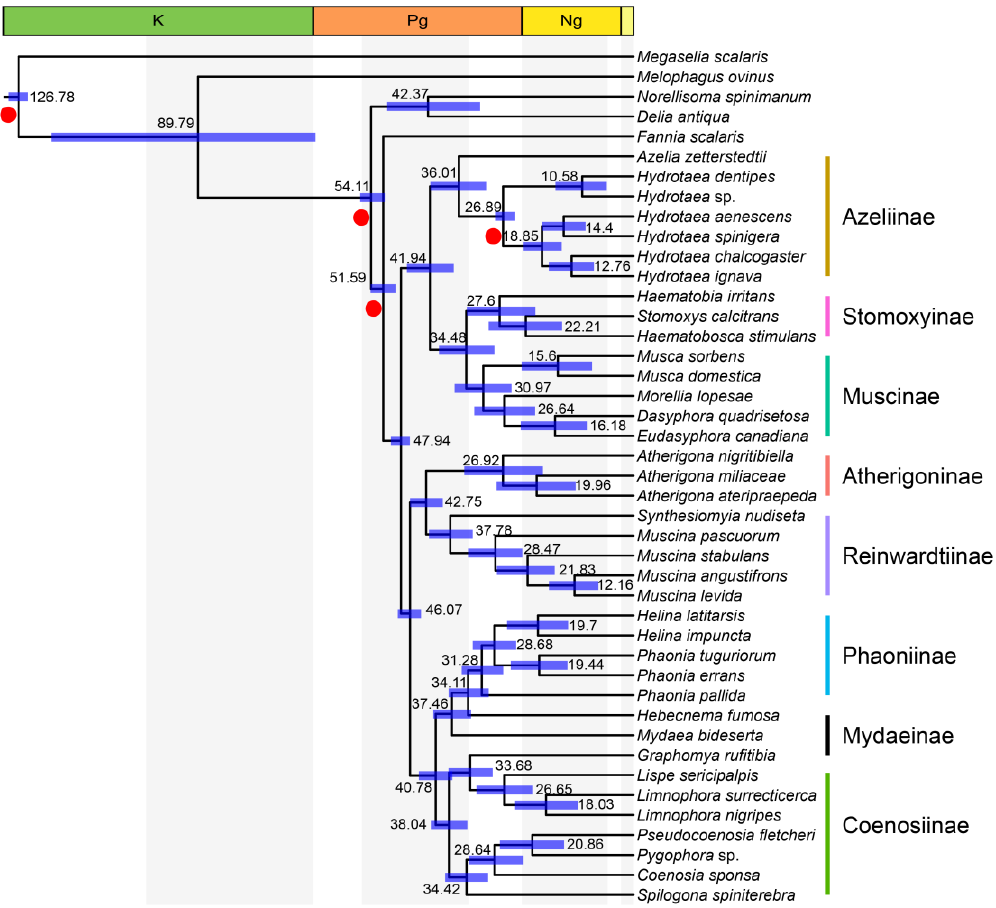
Figure 4. Estimation of Muscidae divergence time by MCMCTree . Different vertical color stripes represent subfamilies in Muscidae; the red points on nodes are time calibration records.